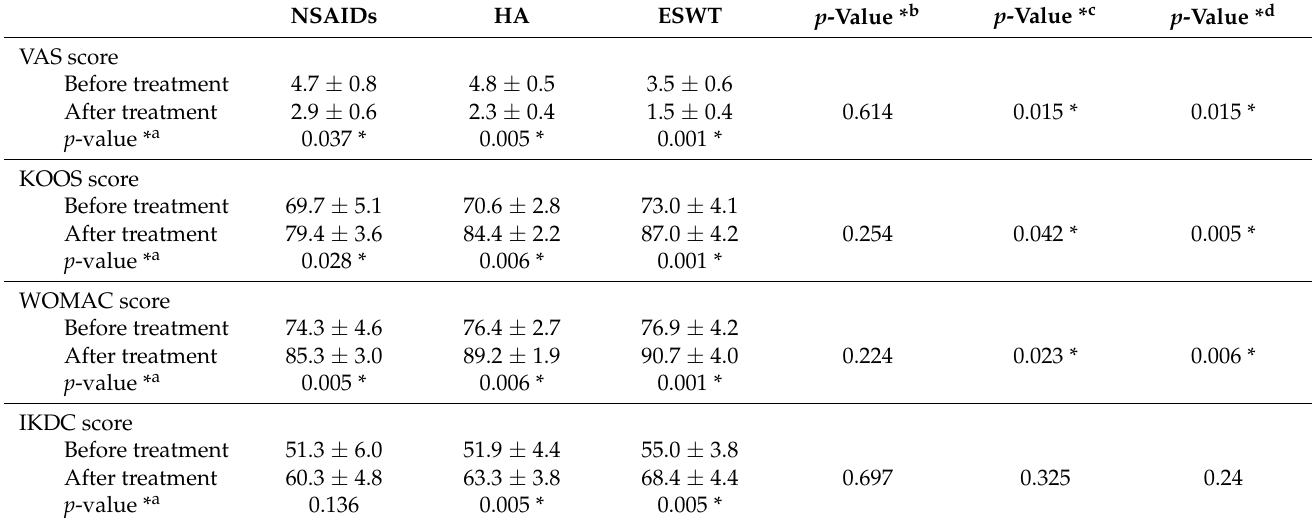
Table 2. The results of pain scores and functional outcomes between the three groups before and after